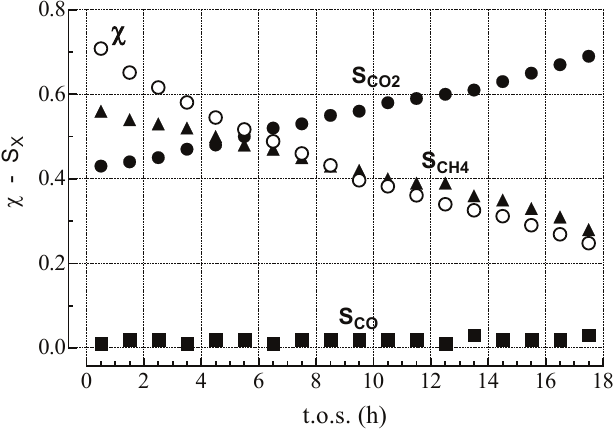
Figure 1. n-hexane conversion ( χ ) and product selectivity (S χ ) vs. t.o.s. at standard